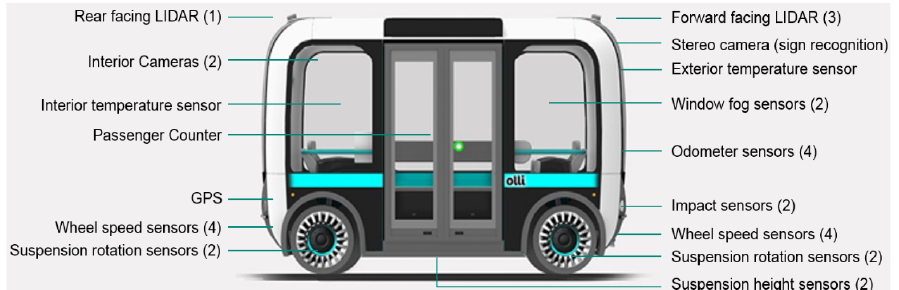
Fig. 7 – Digital Transformation: The Transportation Alloy – Alliance of Autonomy, IoT, Telecommunications and 3D Printing 66 (illustration extracted from [ 9